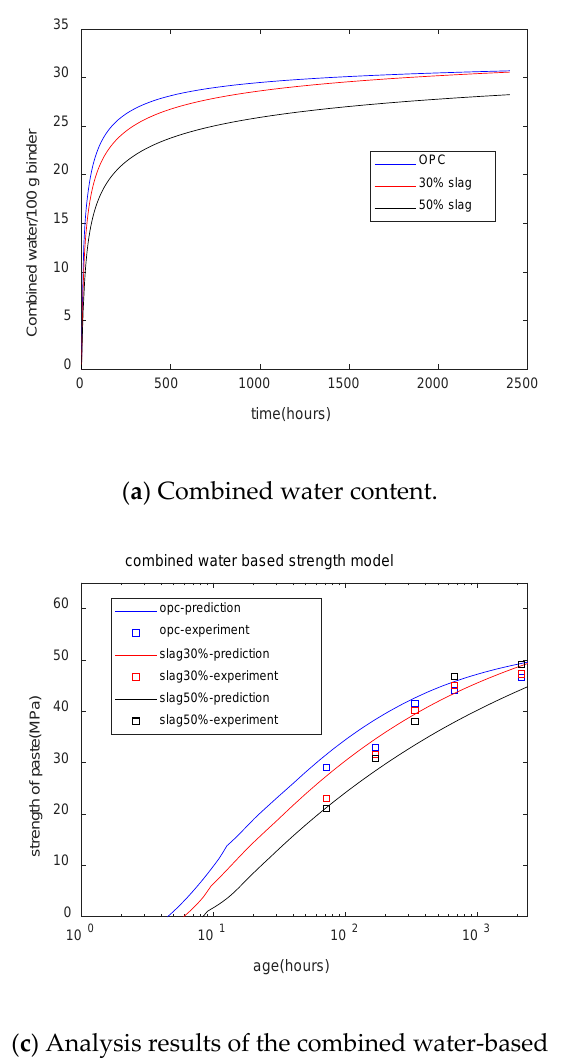
Figure 9. Combined water-based strength model.